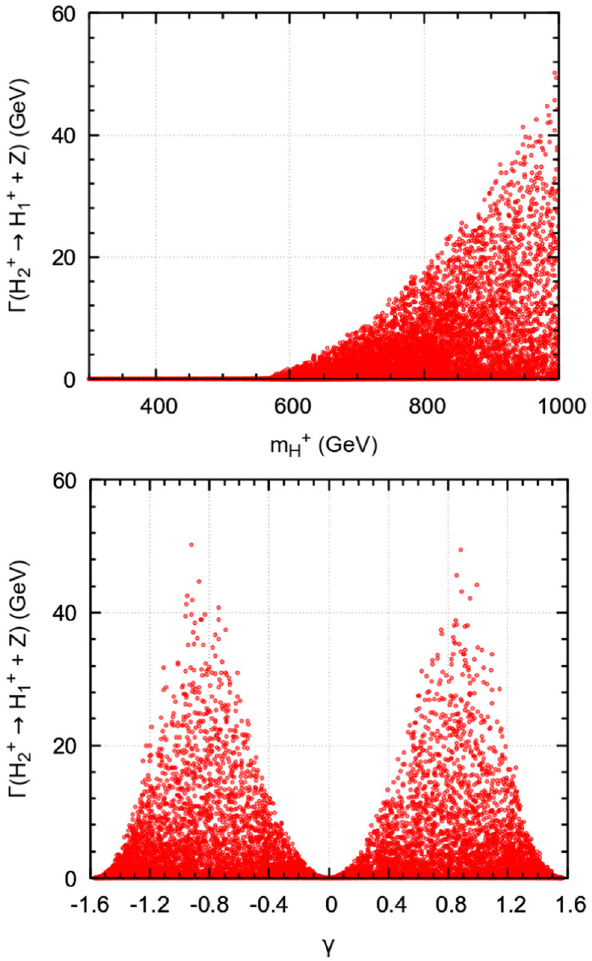
→ H + + Z . On the upper panel the depen- Fig. 9 Decay with H + 2 1 denceonthemassofthedecayingchargedHiggsandonthelowerpanel the dependence on the mixing angle